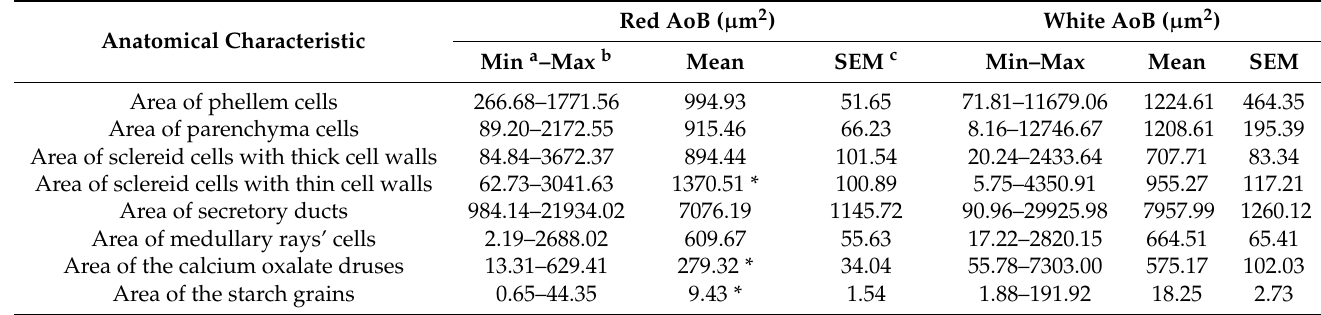
Table 2. A. occidentale bark anatomical characteristics quantification.